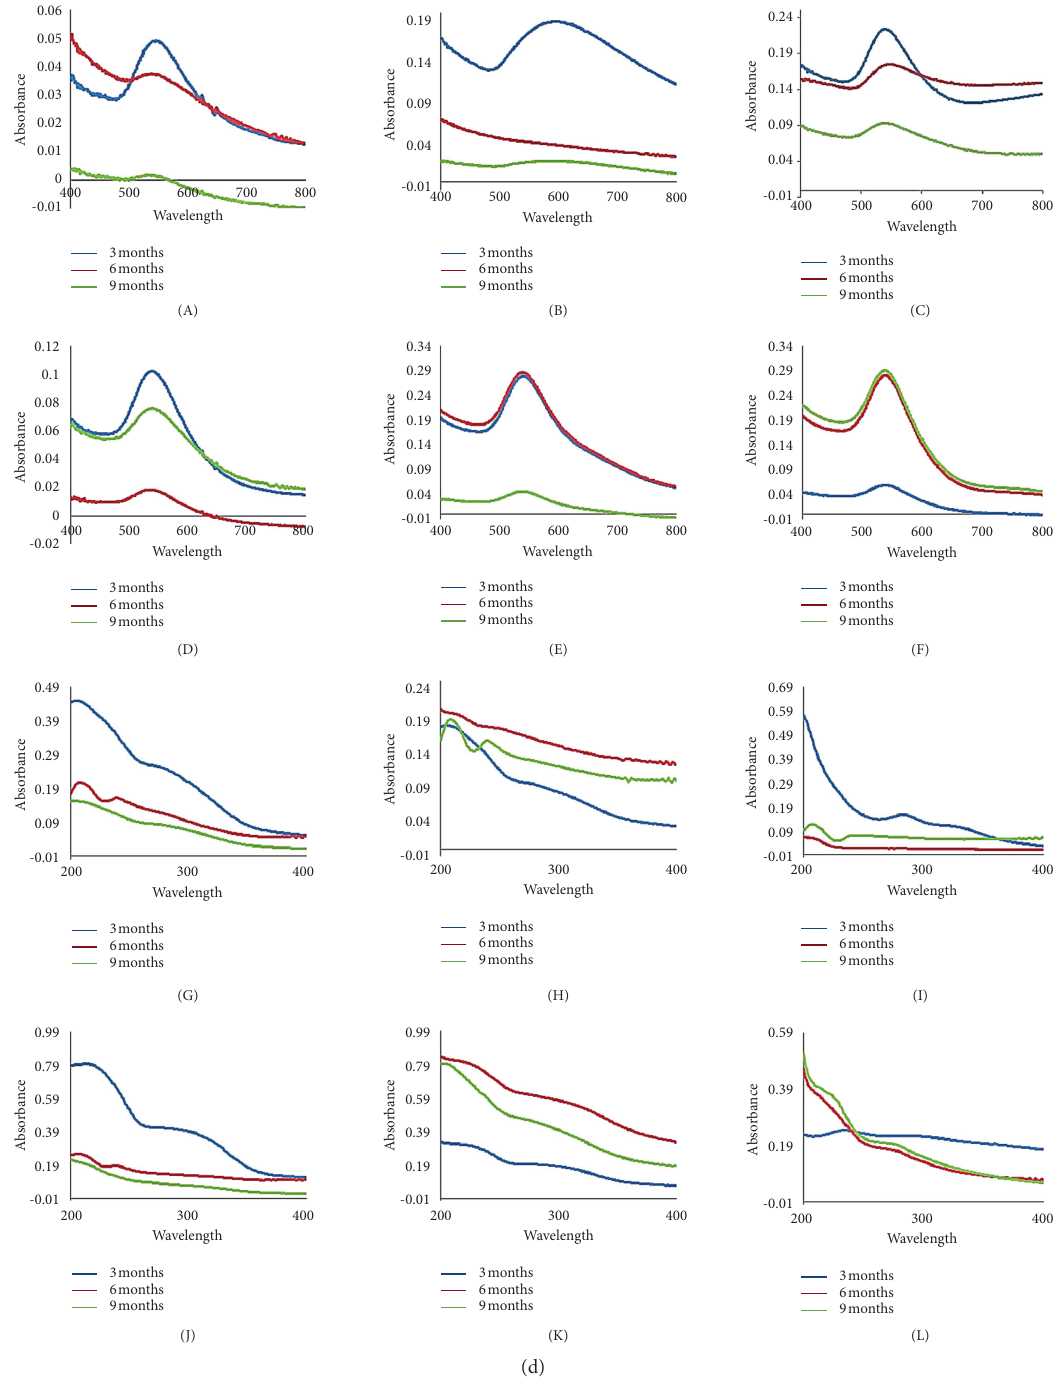
Figure 1: (a) Color change of extract showing the synthesis of different gold nanoparticles (AuNPs). (b) Color change of extract showing the synthesis of different iron nanoparticles (FeNPs). (c) UV-visible spectrum of (A) Phyllanthus emblica AuNPs ( P. emblica AuNPs), (B) Syzygium cumini (AuNPs) ( S. cumini AuNPs), (C) Mentha piperita AuNPs ( M. piperita AuNPs), (D) Rosa indica AuNPs ( R. indica AuNPs), (E) Mallotus philippensis AuNPs ( M. philippensis AuNPs), (F) Ficus microcarpa AuNPs ( F. microcarpa AuNPs), (G) Phyllanthus emblica FeNPs ( P. emblica FeNPs), (H) Syzygium cumini FeNPs ( S. cumini FeNPs), (I) Mentha piperita FeNPs ( M. piperita FeNPs), (J) Rosa indica FeNPs ( R. indica FeNPs), (K) Mallotus philippensis FeNPs ( M. philippensis FeNPs), (L) Ficus microcarpa FeNPs ( F. microcarpa FeNPs). (d) UV-visible spectrum showing stability of (A) P. emblica AuNPs, (B) S. cumini AuNPs, (C) M. piperita AuNPs, (D) R. indica AuNPs, (E) M. philippensis AuNPs, (F) F. microcarpa AuNPs, (G) P. emblica FeNPs, (H) S. cumini FeNPs, (I) M. piperita FeNPs, (J) R. indica FeNPs, (K) M. philippensis FeNPs, (L) F. microcarpa